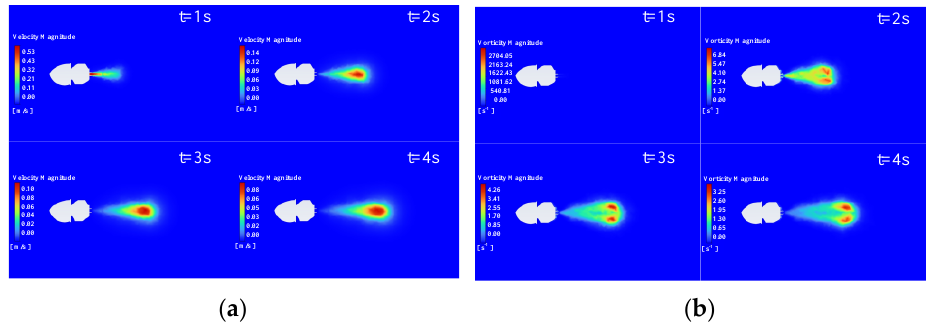
Figure 10. Flow field variation during jetting of the bionic jellyfish robot with 15 mm diameter nozzle ( a ) velocity nephograms at different moments; ( b ) vorticity maps at different moments. t=1s t=2s